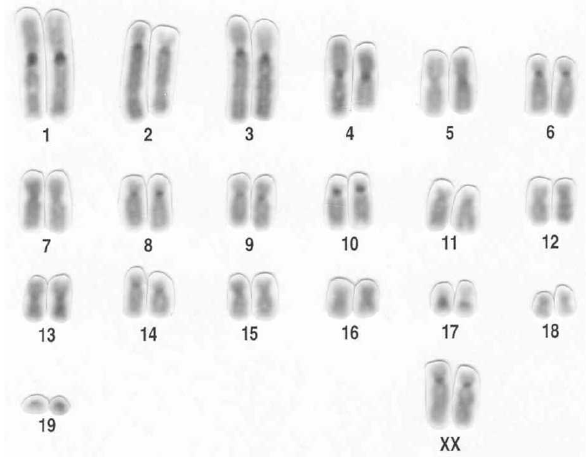
Figure 2 - C-banded karyotype of a S. a. ingrami female (2n = 40, FN = 74) showing small pericentromeric heterochromatin in pairs 1, 2, 3, 4, 6, 7, 9, 10, and 11, and at the secondary constriction of the submeta- centric 17.